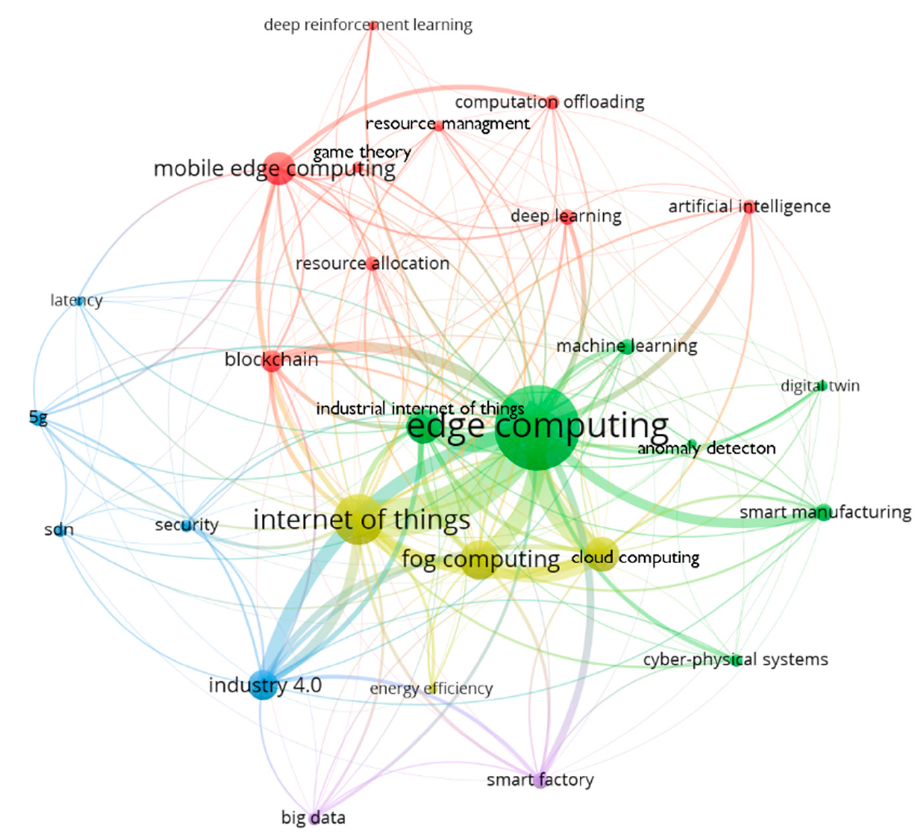
Figure 2. Term network visualization in VOSviewer version 1.6.16.